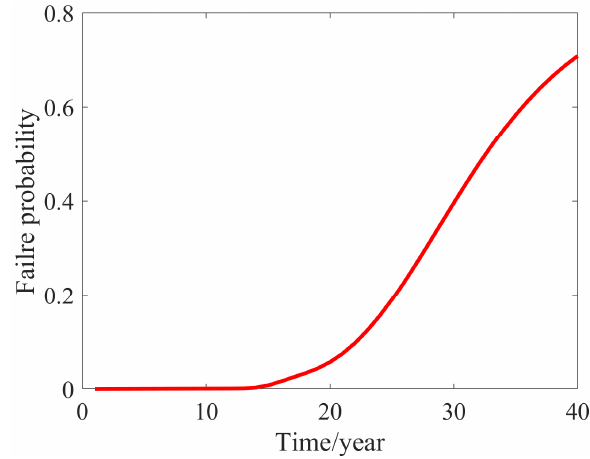
Figure 14. The DBN of fatigue failure.